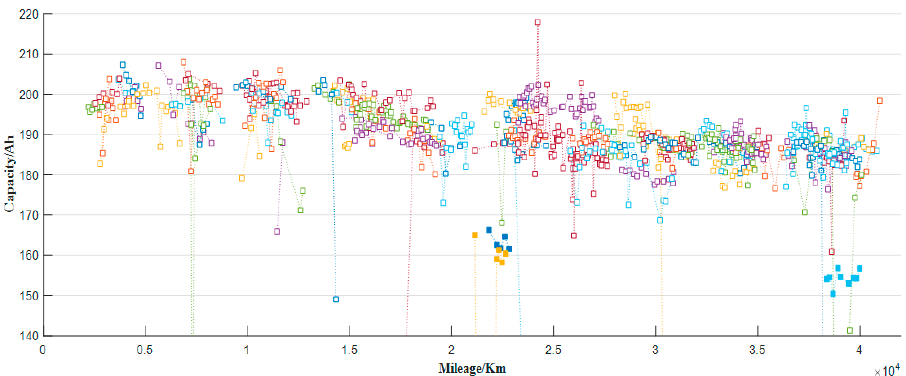
Figure 8. Estimation of discharge capacity of 100 real vehicles.